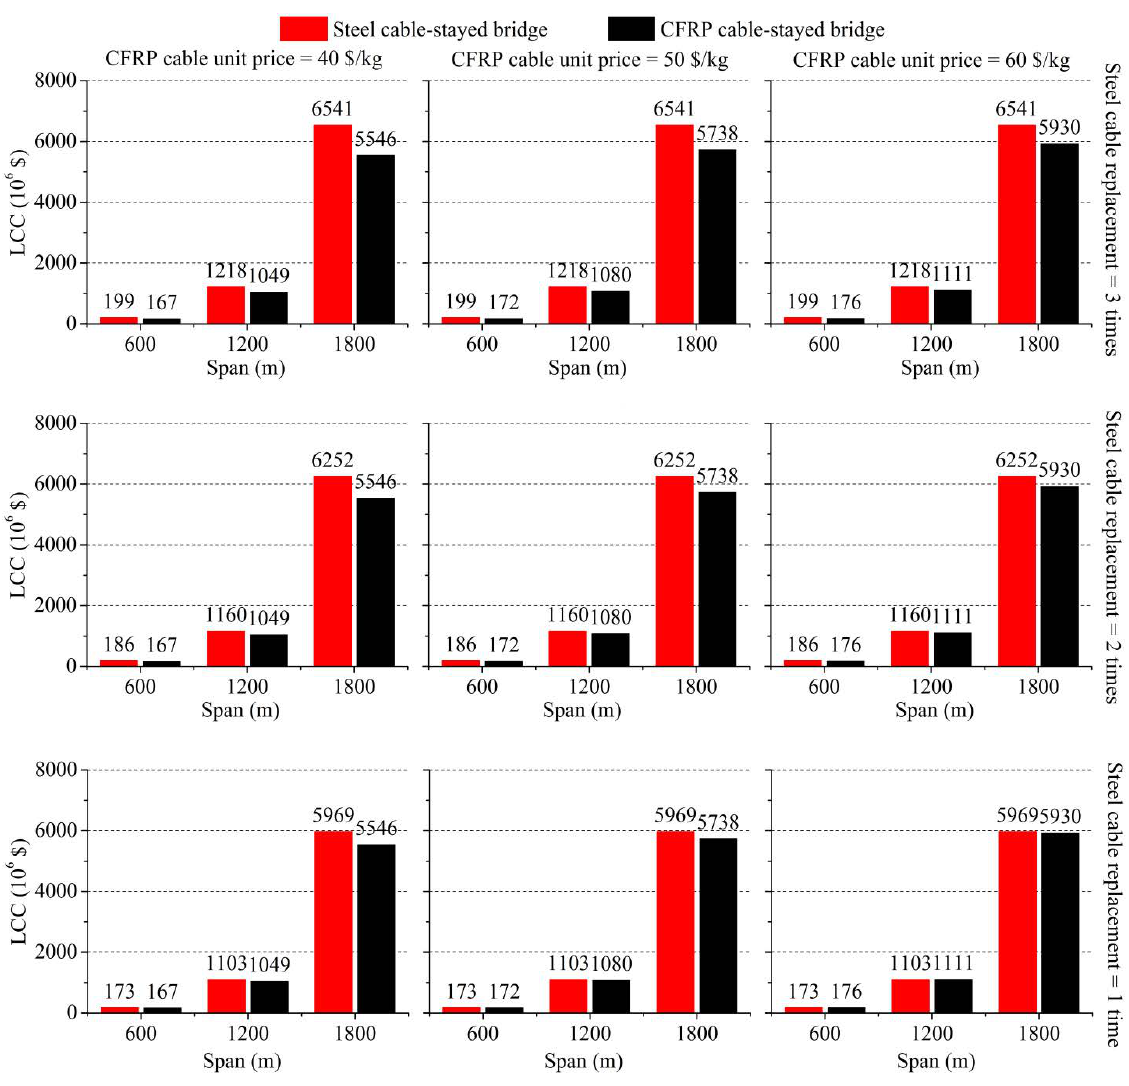
Figure 7. Detailed comparison of life-cycle cost results.